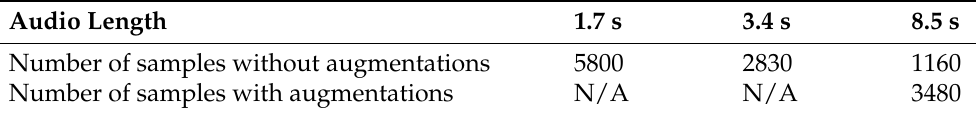
Table 2. Number of samples in each time split, with and without